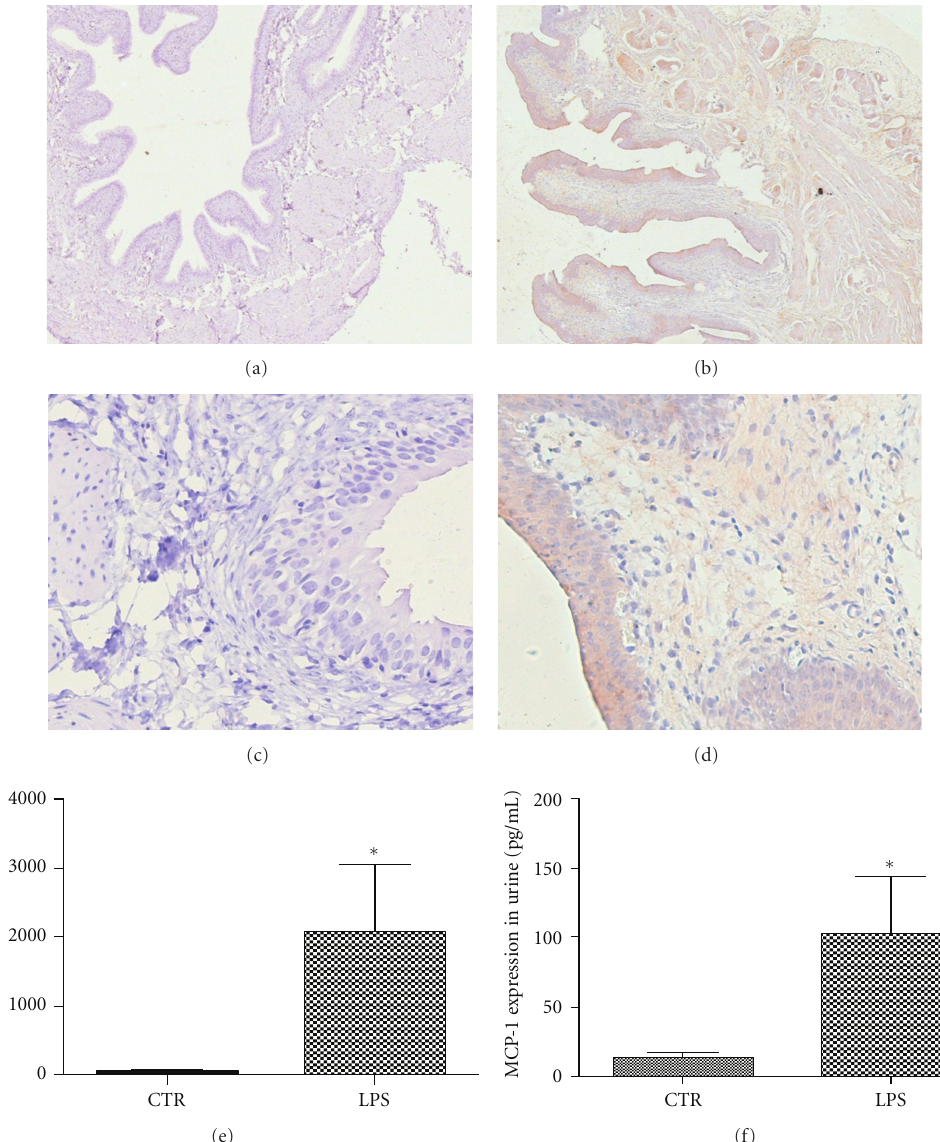
Figure 1: MCP-1 immunodetection. LPS-treated rats showed increased expression of MCP-1 in bladder tissues. (a) and (c) Control group ( n = 3); (b) and (d) Model group ( n = 6). ((a) and (b): × 40; (c) and (d): × 400). ELISA results indicate that MCP-1 levels in bladder tissue (e) and urine (f) from the Model group were elevated compared to levels observed in the Control group ( P < 0 .